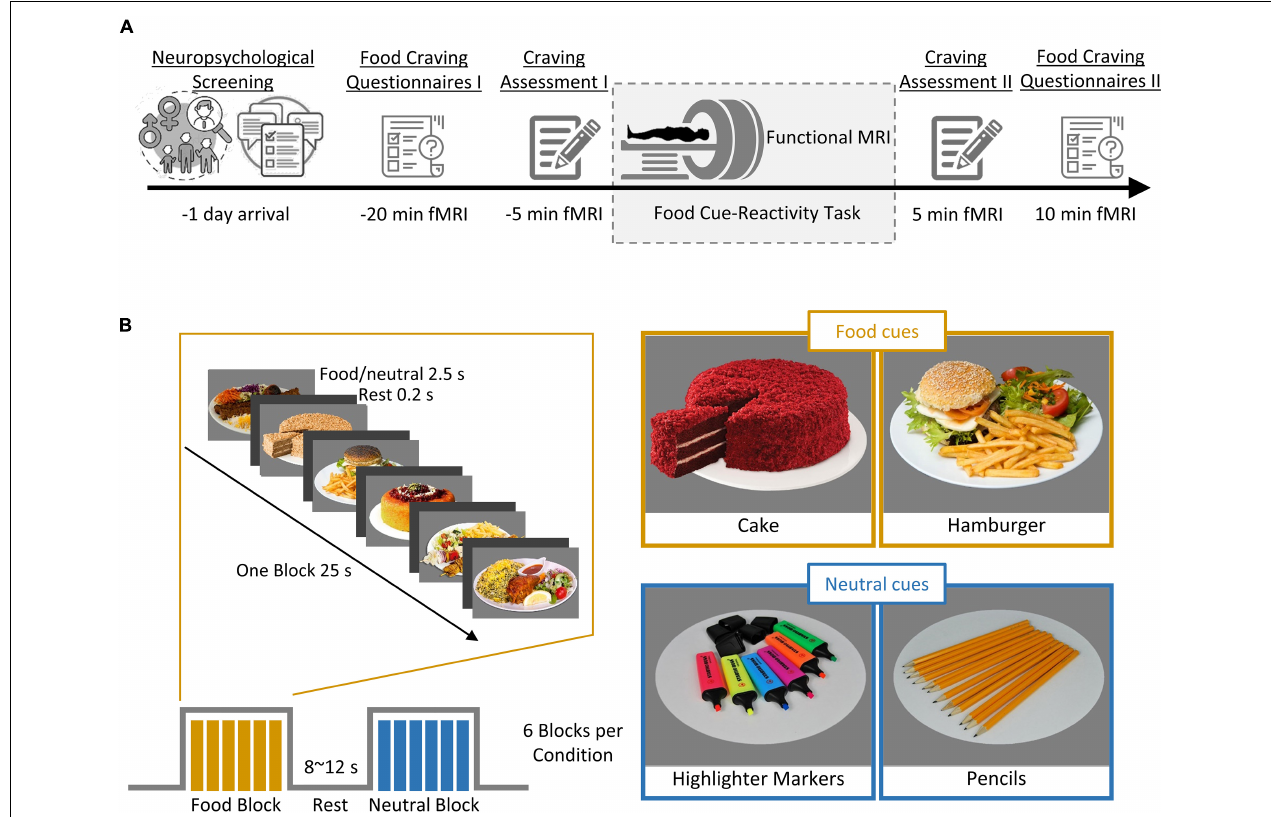
FIGURE 1 | Outline of the experimental procedure and cue-reactivity paradigm. (A) Experimental procedure. First, individuals underwent screening for their neuropsychological functioning (measured by self-reported questionnaire; see Table 1 for details). Each participant ( n = 50) then underwent a food cue-reactivity training task. On the experiment day, participants completed two food craving questionnaires: FCQ-state and FCQ-Trait and subsequently underwent an MR scan with the food cue-reactivity task. Immediately before and after the MR scan, participants rated their self-reported food craving, hunger, and affective states (anger, anxiety, awareness, drowsiness, happiness, sadness). (B) Food cue-reactivity paradigm. In the food cue-reactivity task, participants saw 12 blocks of 6 pictures each (six blocks with food cues and six blocks with neutral cues). Each block was followed by an inter-block interval with a duration between 8 and 12 s. In total, participants saw 72 cues over 342